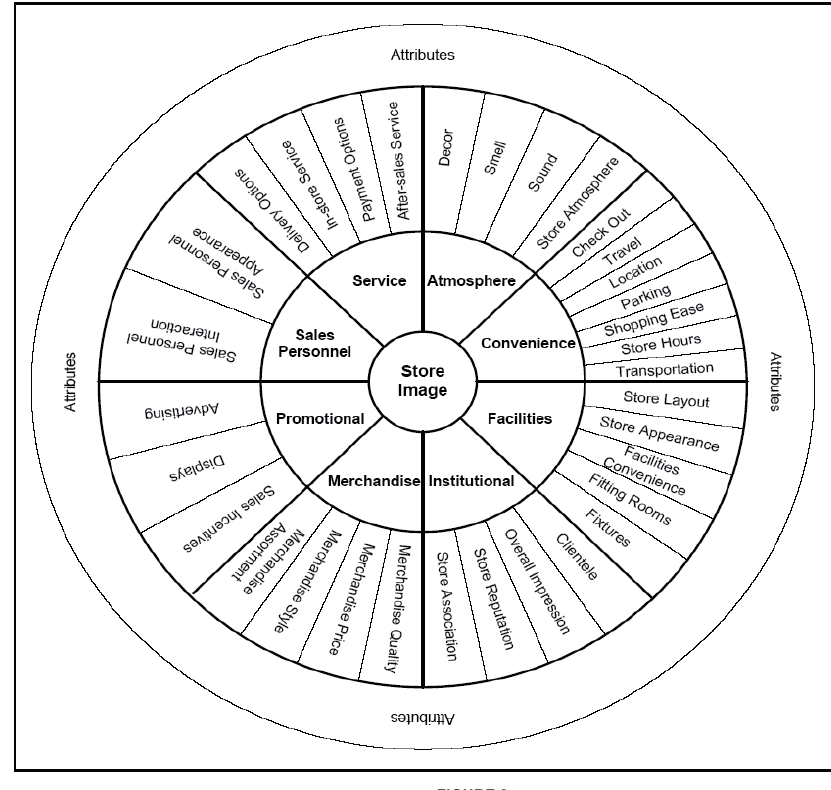
Figure 2 Proposed conceptual model of the underlying structure of store